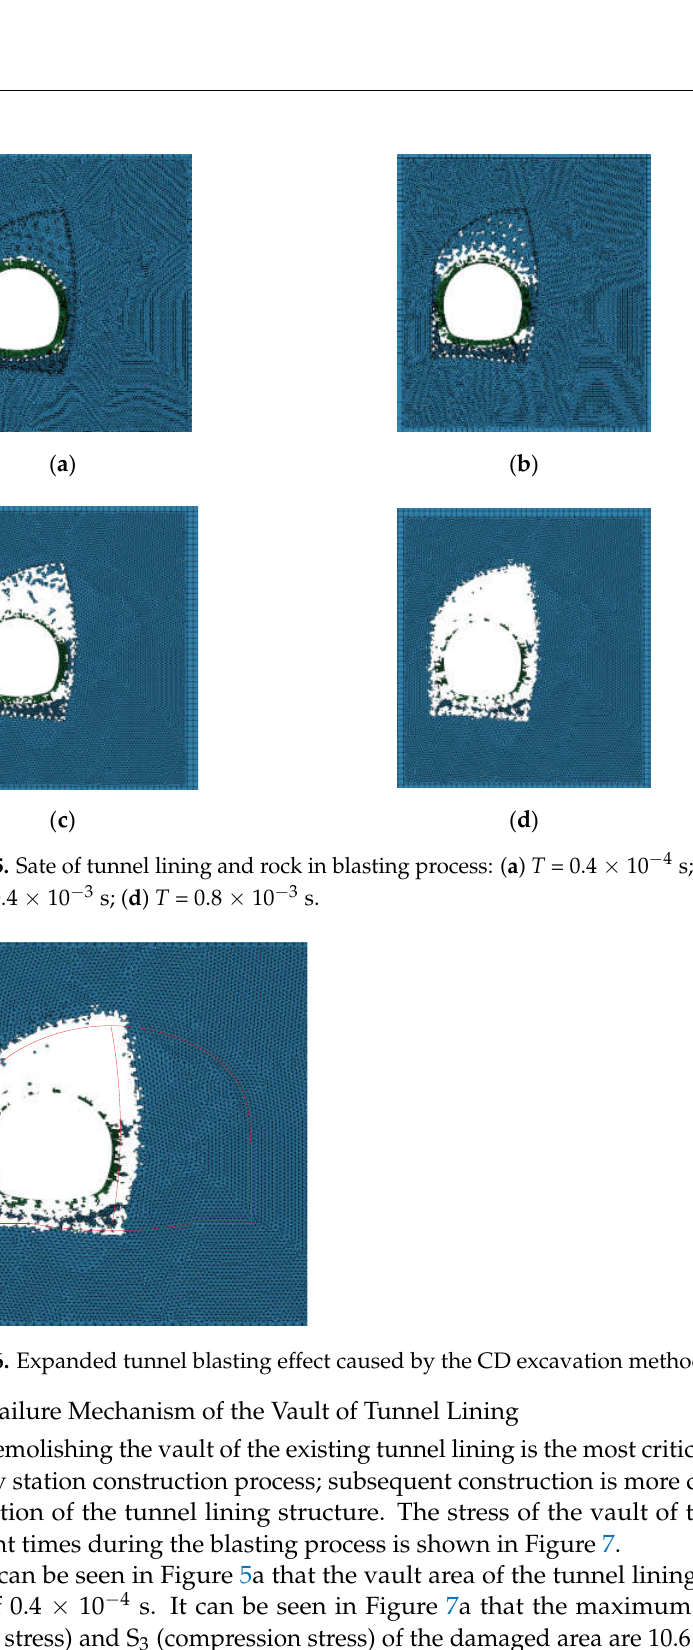
Figure 6. Expanded tunnel blasting effect caused by the CD excavation method.